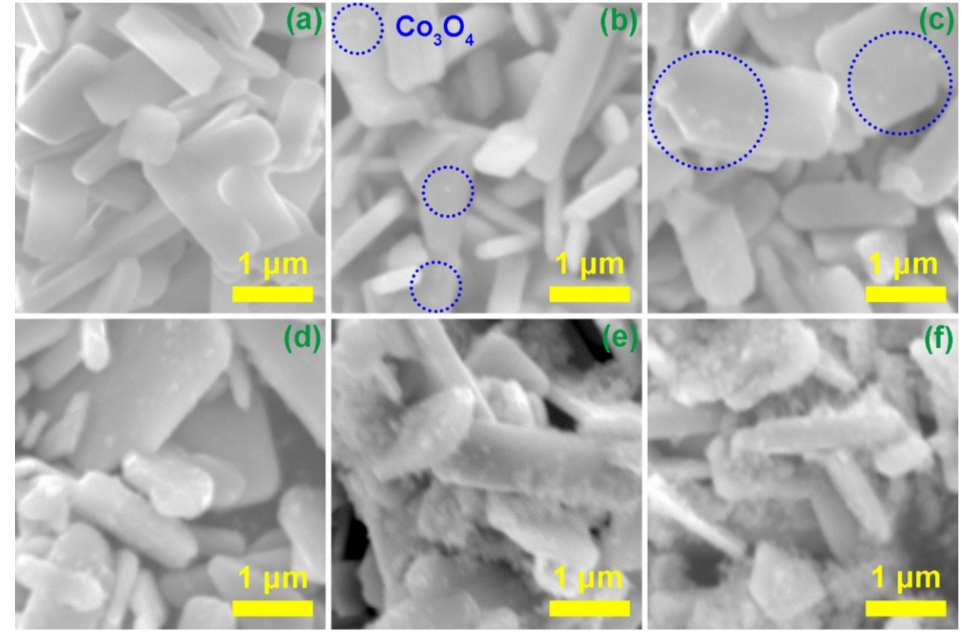
Figure 2. SEM images of ( a ) La 2 Ti 2 O 7 , ( b ) LC1, ( c ) LC2, ( d ) LC3, ( e ) LC4, and ( f )